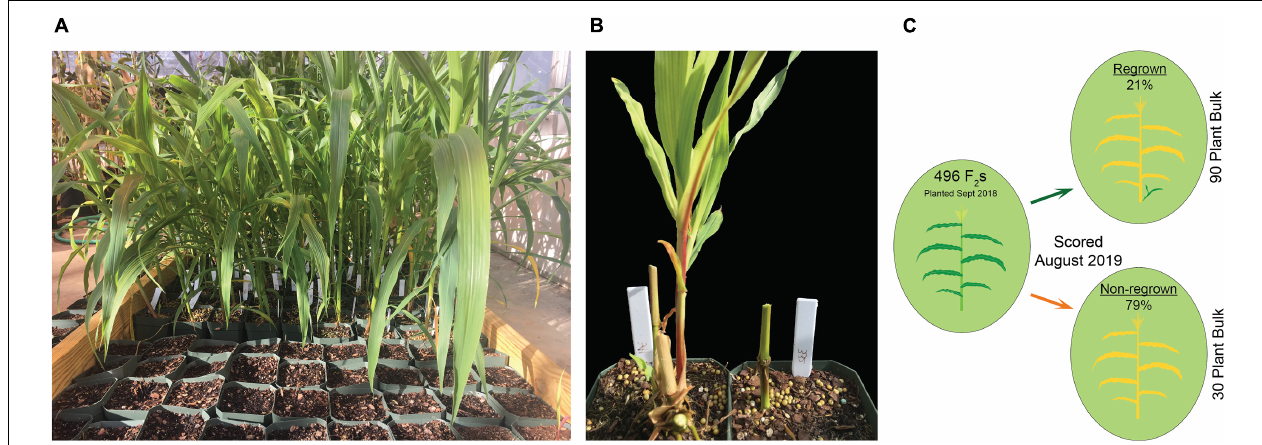
FIGURE 1 | Growth conditions for scoring regrowth in F 2 populations. (A) Seedlings were grown in square four-inch pots over a moist coconut mat. (B) Following flowering and senescence, regrown (left) and non-regrown (right) plants were scored. (C) Schematic for QTL-seq experiment. 496 P39/“Gigi” F 2 s were planted in September 2018 and scored in August 2019 for regrowth (21%; top) and non-regrowth (79%; bottom). QTL-seq was carried out on a 90-plant regrown bulk and a 30-plant non-regrown